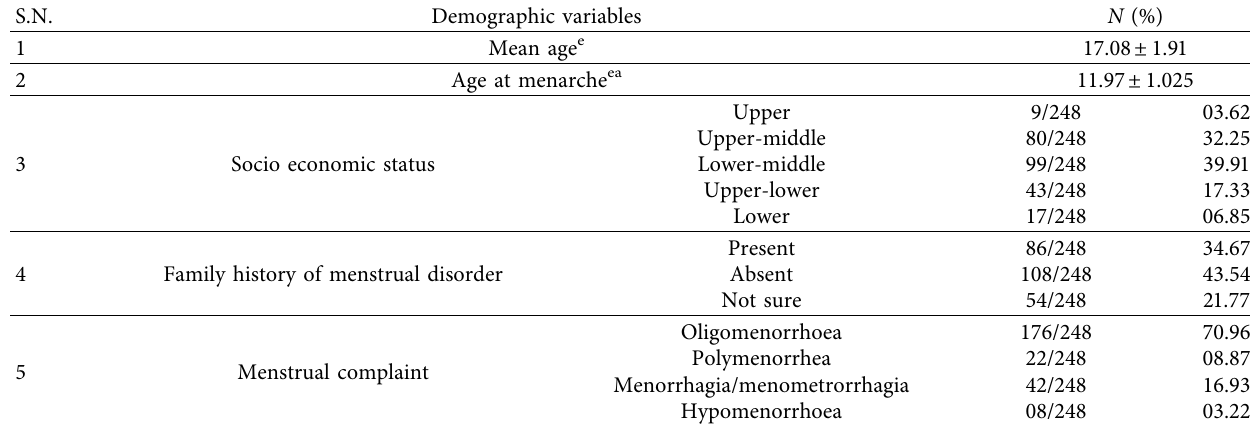
Table 1: Demographic and clinical characteristics of study